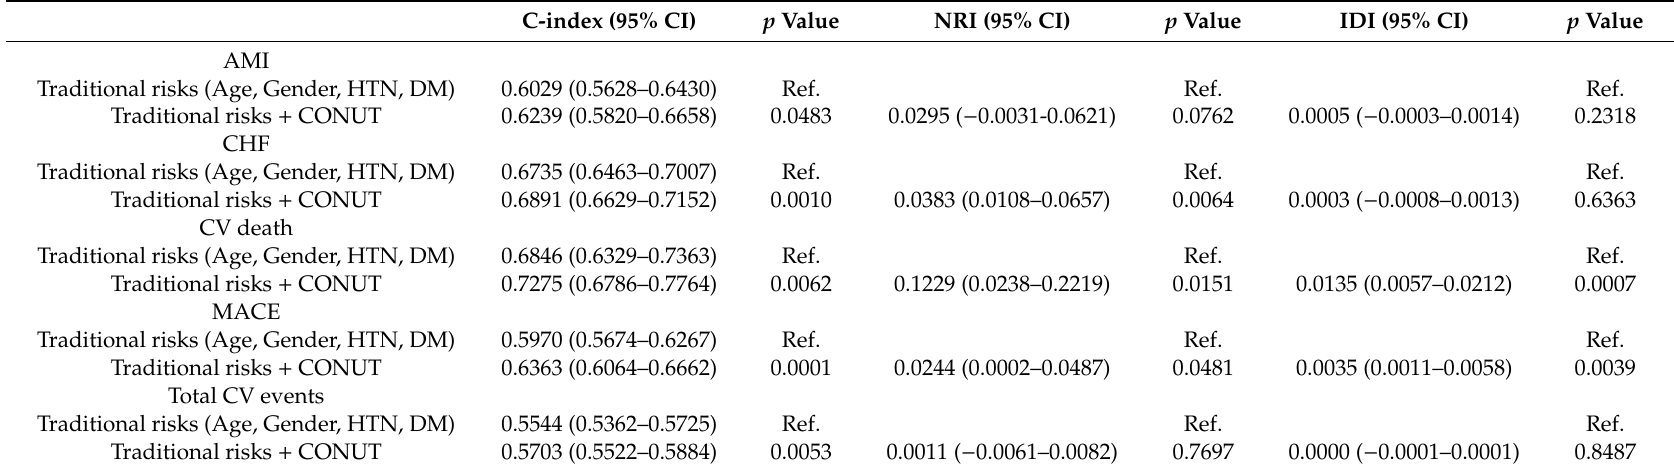
Table 4. Improvement in discrimination performance and calibration for risk prediction of cardiovascular events in the multivariate-adjusted model after including CONUT